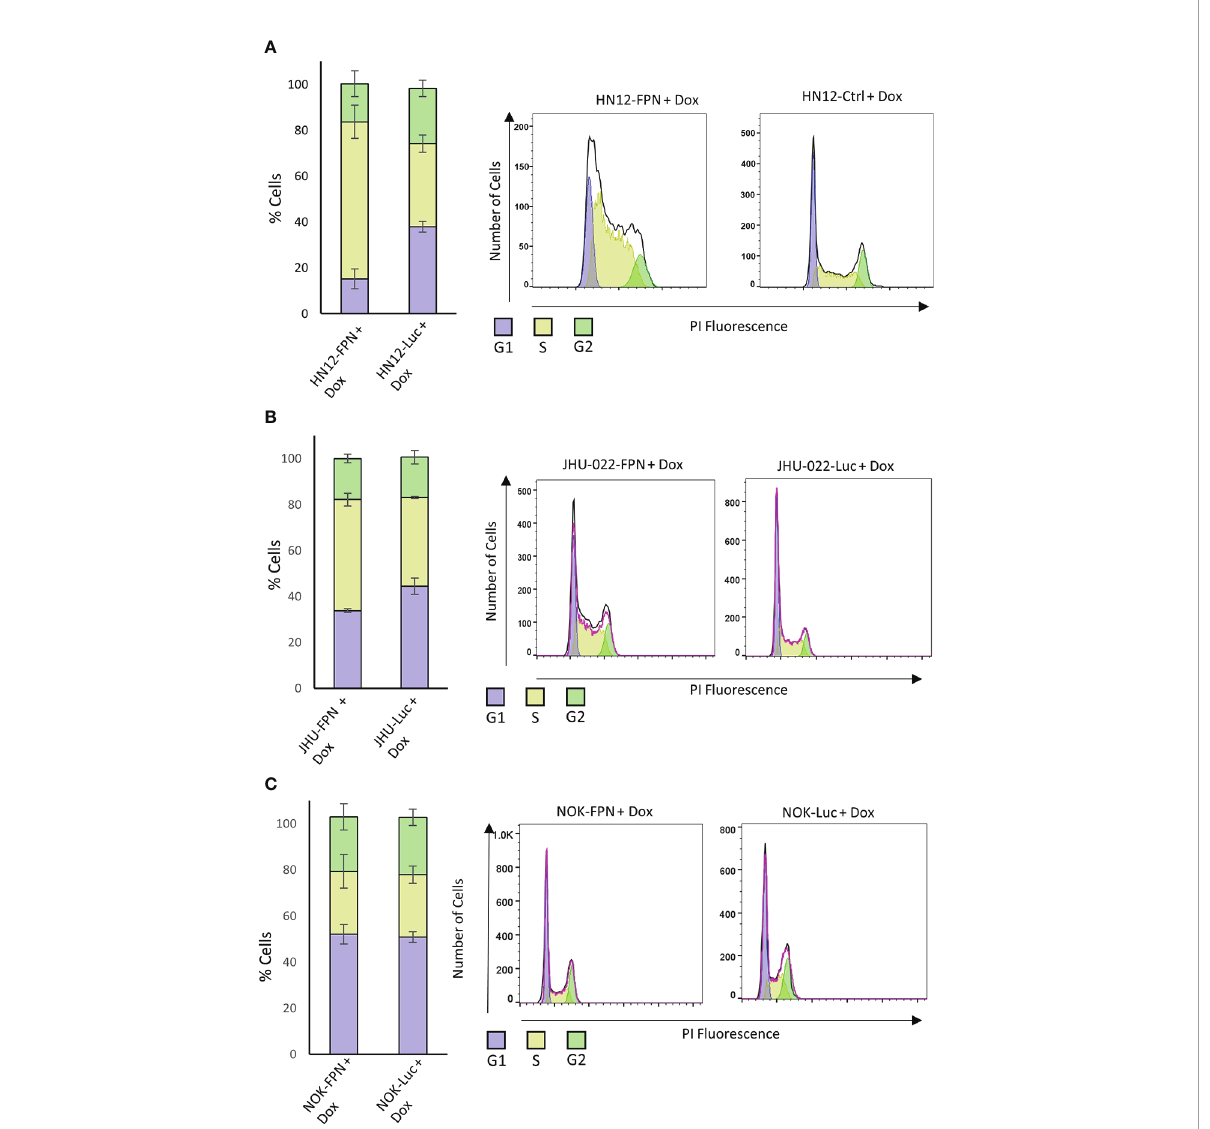
FIGURE 5 Ferroportin expression causes cell cycle arrest in HNSCC. FPN or Luciferase control expressing HN12 (A) , JHU-022 (B) and NOK (C) were grown with 0.5 m g/mL dox for 3 (HN12) or 4 days (NOK, JHU-022) and stained with propidium iodide to measure DNA content. The DNA content was assessed by fl ow cytometry and the cell cycle distribution was analyzed using FlowJo. All data is representative of 3 biological